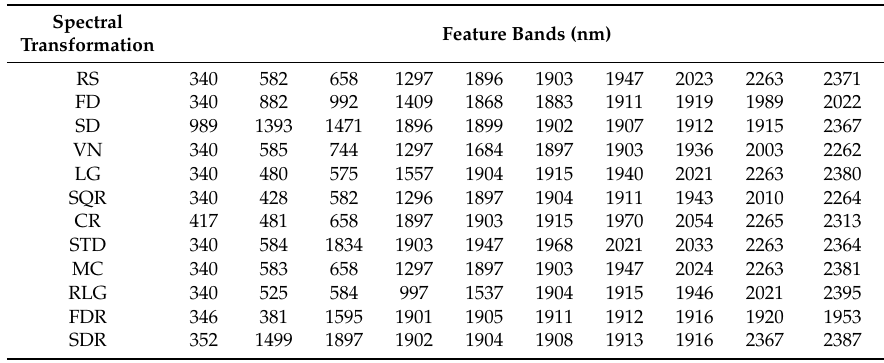
Figure 7. The selected bands of different transformation ( a ) the raw reflectance spectra (RS), ( b ) the first derivative of the reflectance spectra (FD), ( c ) the second derivative of the reflectance spectra (SD), ( d ) the vector normalization of the reflectance spectra (VN), ( e ) the logarithm of the reflectance spectra (LG), ( f ) the square root of the reflectance spectra (SQR), ( g ) the continuum removal of the reflectance spectra (CR), ( h ) the standardization of the reflectance spectra (STD), ( i ) the mean center of the reflectance spectra (MC), ( j ) the reciprocal of logarithmic of reflectance spectra (RLG), ( k ) the first derivative of reciprocal of the reflectance spectra (FDR), and ( l ) the second derivative of the reciprocal of the reflectance spectra (SDR). Table 4. Feature bands selected by the SPA method.